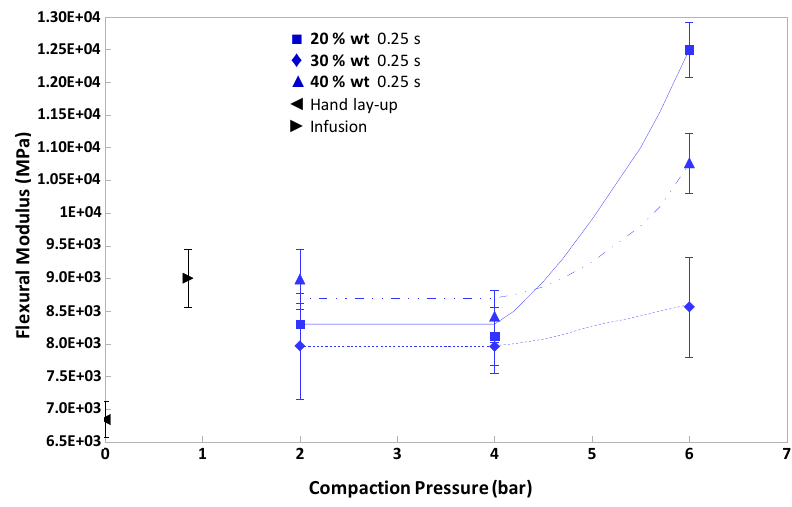
Figure 17. Flexural moduli of the composites with prepreg fibre contents of 20 ( ■ ), 30 ( ♦ ), and 40 wt.% ( ▲ ) and an initial exposure time of 0.25 s vs. the compaction pressure.